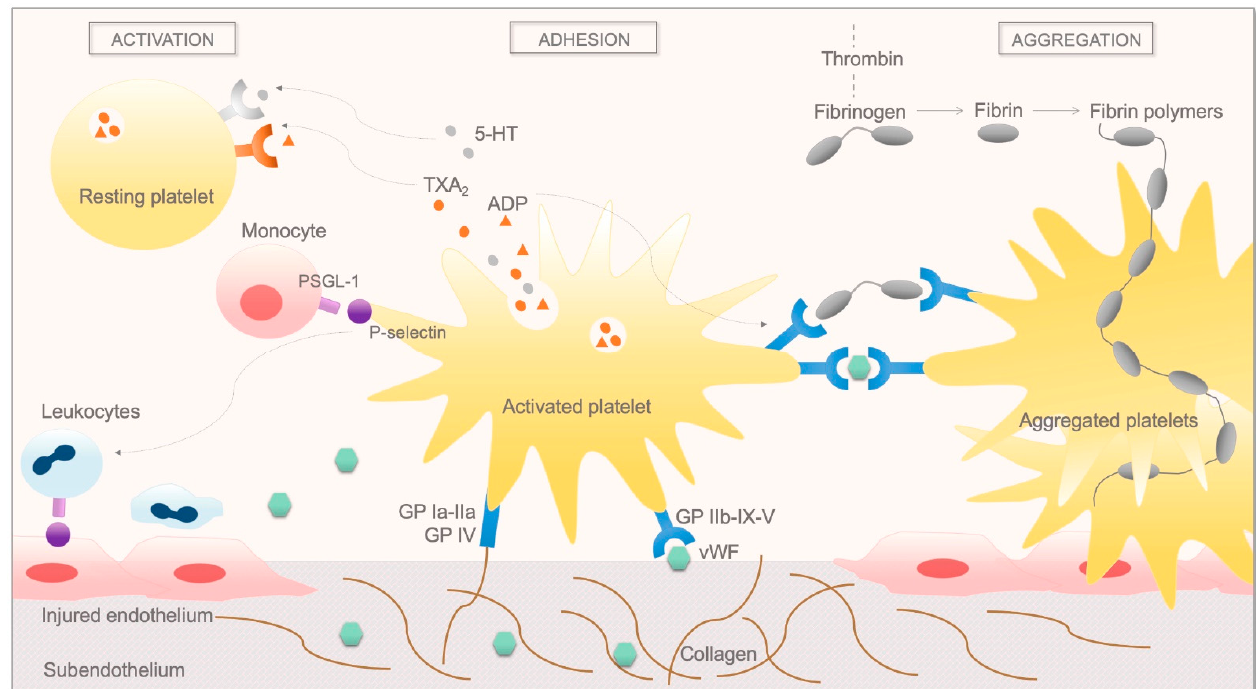
Figure 2. The mechanism of platelet adhesion and aggregation. 5-HT—serotonin; ADP—adenosine diphosphate; GP Ia-IIa—glycoprotein Ia-IIa; GP IIb-IX-V—glycoprotein IIb-IX-V; GP IV—glycoprotein IV; PSGL-1—P-selectin glycoprotein ligand 1; TXA2—thromboxane-A2; vWF—von Willebrand factor.